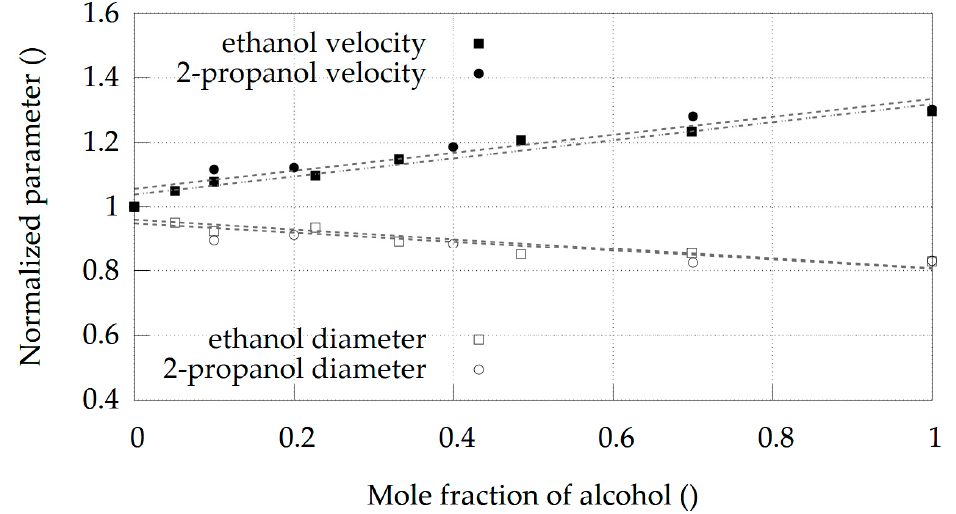
Figure 5. Normalized jet diameter, D 0 , and velocity, U 100 , at various molar fractions, X i , for two different alcohols. Filled circles and squares denote the velocities, while empty ones show the diameters. The dotted lines depict the corresponding best fit to the available dataset (linear function).